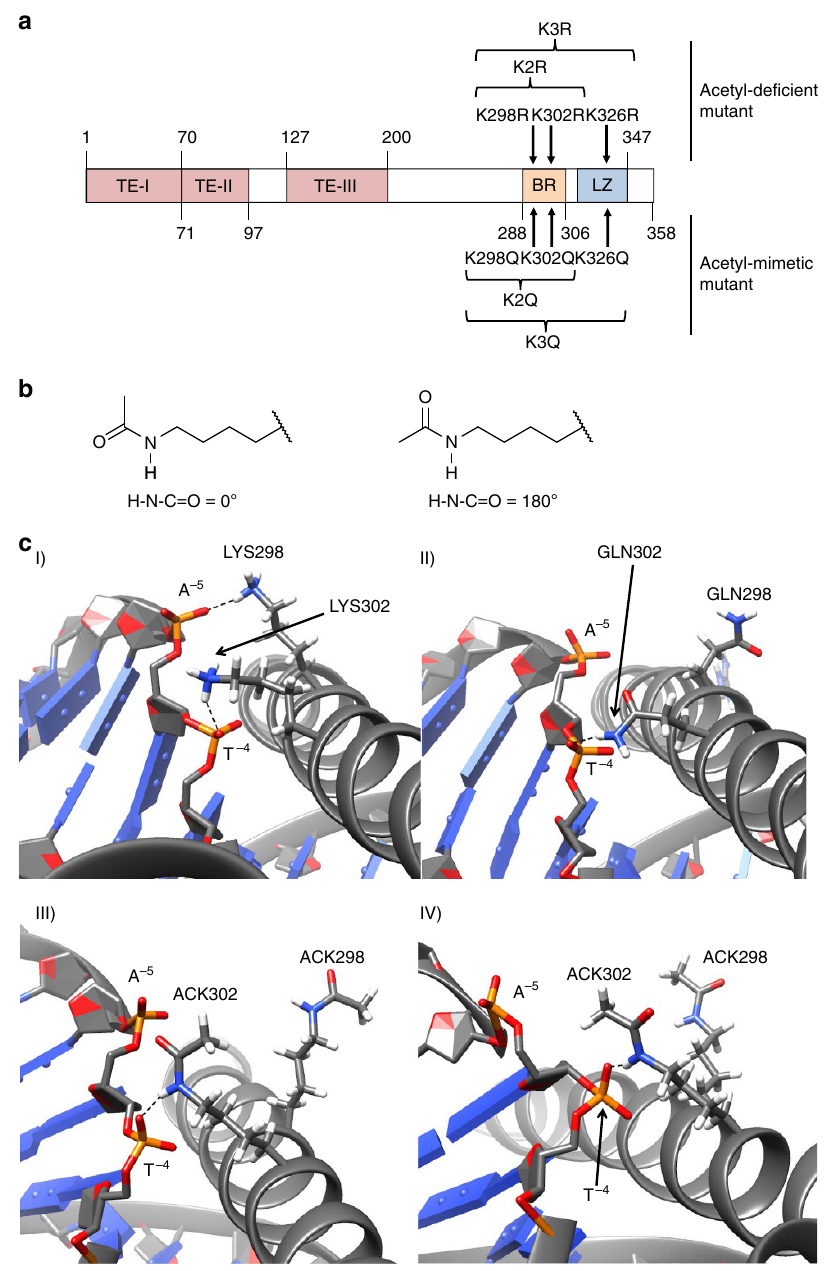
Figure 3 | Molecular dynamics simulation of acetylation at K298 and K302. ( a ) Diagram of the C/EBP a protein. The positions of the three transactivation elements (TEs), basic region-leucine zipper (BR-LZ) and putative acetylation sites for GCN5 are indicated. ( b ) The two conformations of the acetylated lysine (ACK) side chain built into the starting coordinates of the acetylated models and preserved during the MD simulations. ( c ) MD snapshots during 3ns simulation showing selected protein–DNA interactions: I) C/EBP a WT-DNA; II) K2Q-DNA; III) K2Ac_a-DNA; and IV) K2Ac_b-DNA. Hydrogen bonds are shown as dashed lines.